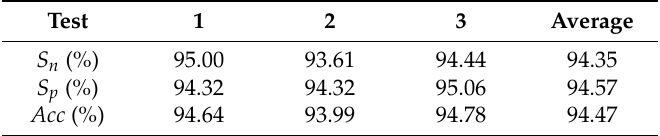
Table 7. Results of the three cross-validation tests with the 27-D